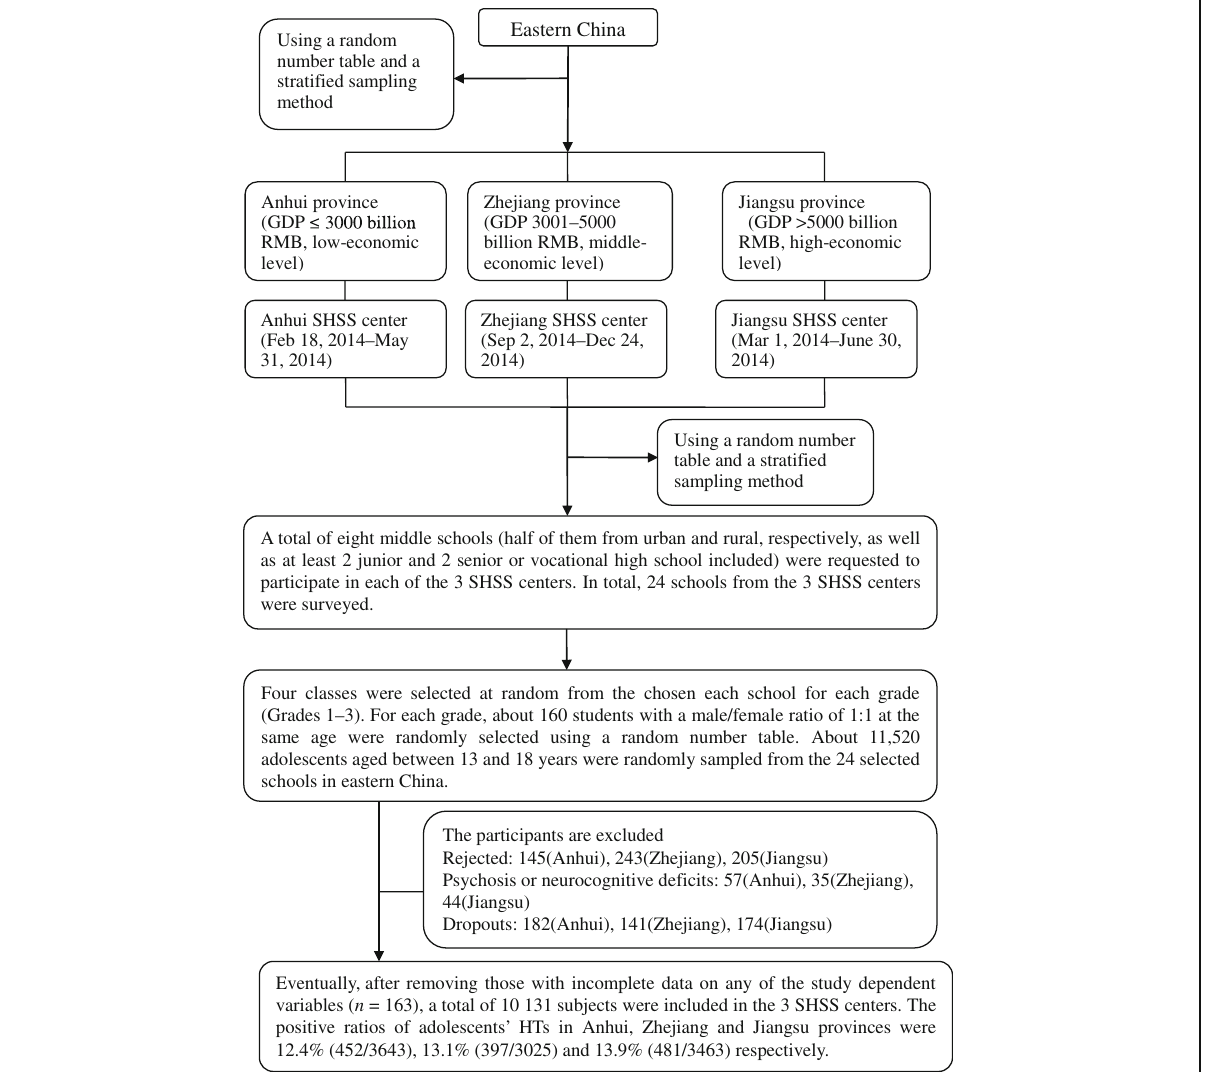
Fig. 1 Data sampling. The prevalence of adolescents ’ HTs did not seem to be connected with their economic levels ( P > 0.05). GDP gross domestic product, SHSS School Health Surveillance System, HTs hysterical